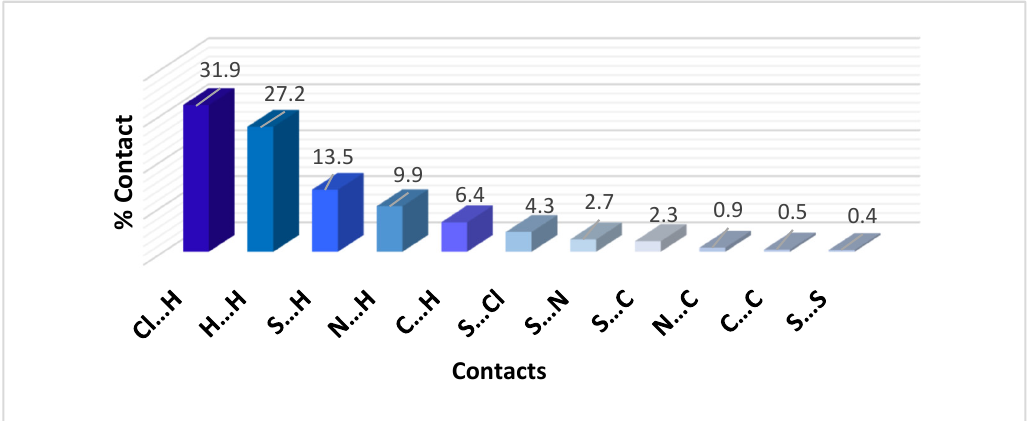
Figure 6. Intermolecular interaction and percentages of all contact contributions to the total Hirshfeld surface analysis.